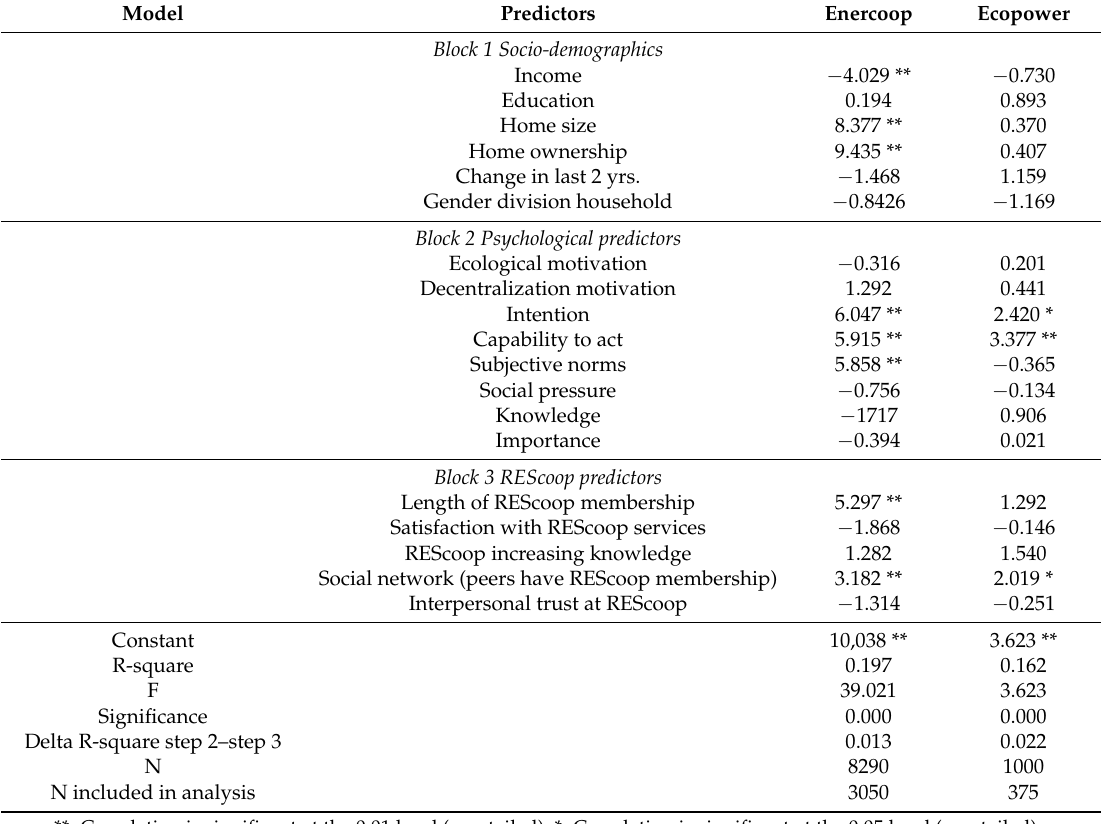
Table 9. Results of multivariate regression analyses on the sum of individual energy actions